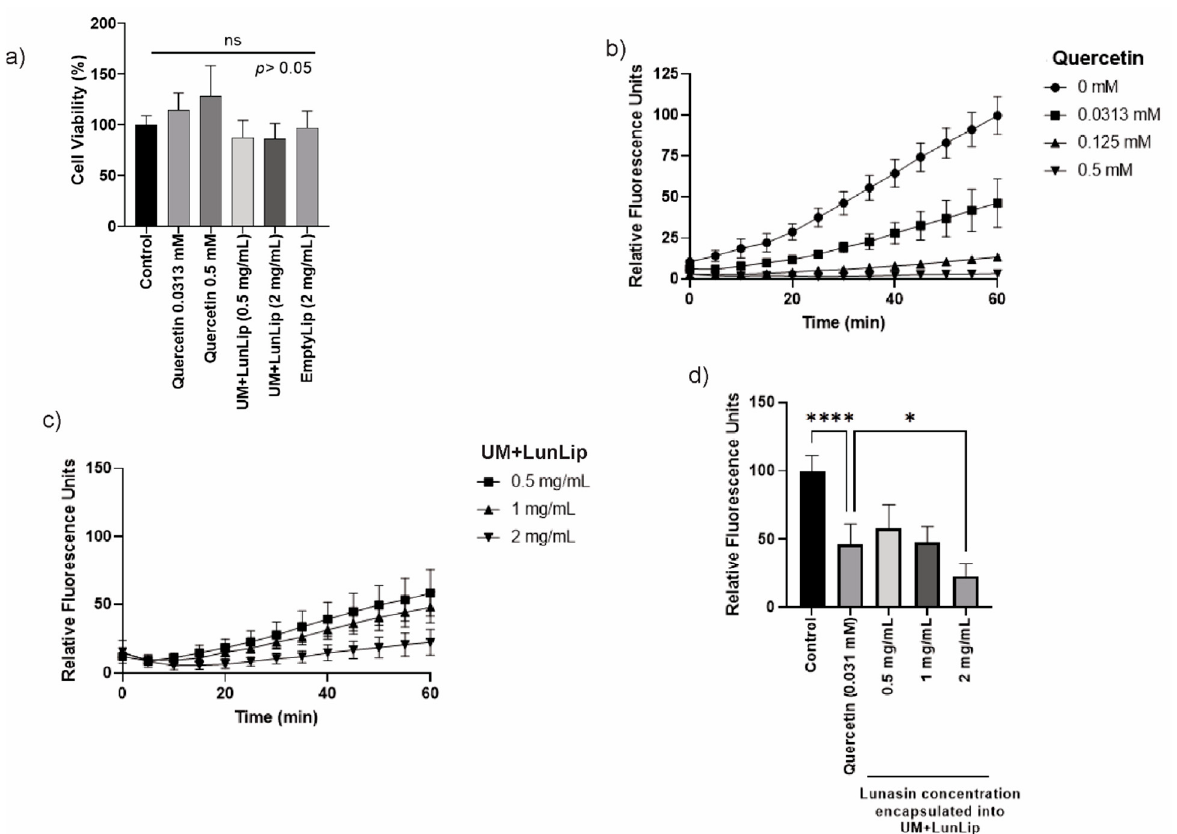
Figure 2. Liposomes prepared with dioleoyl phosphatidylcholine and dioleoyl phosphatidylglyc- erol, and loaded with soybean lunasin and amaranth unsaponifiable matter (UM + LipLun) de- creased ROS production when ABAP was applied to the CHON-002 fibroblasts. ( a ) Cell viability of CHON-002 after treatment with empty liposomes (EmLip), UM + LunLip, and quercetin. ( b ) Rela- tive fluorescence of dichlorofluorescein (DCF) after treatment with different concentrations of quercetin (0–0.5 mM). ( c ) Relative fluorescence of DCF after treatment with different concentrations of UM + LunLip (0.5–2 mg lunasin/mL). ( d ) ROS production after 1 h treatments with different con- centrations of UM + LunLip; 0.031 mM quercetin was used as the antioxidant control and non-treated cells as the control. The ROS production in cells (from a to c) was stimulated with 600 μ M ABAP. The data are present as the mean of two independent replicates; each was measured in trip- licate. Data are means ± standard deviation. * p < 0.05; **** p < 0.0001. ns, not statistically different.